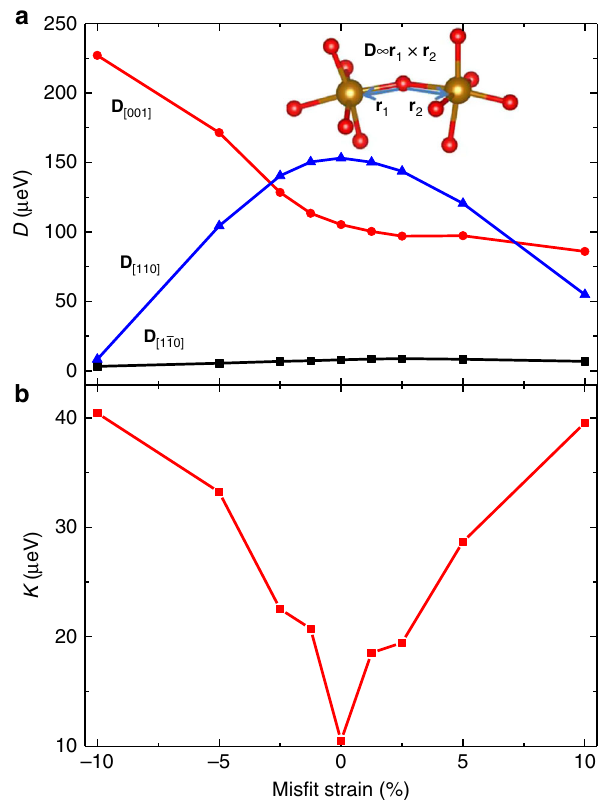
Fig. 4 Magnetic evolution with strain via spin Hamiltonian. a Strain (cid:1) (cid:3) (cid:1) (cid:3) dependence of the in-plane ( 110 , 001 ) and out-of-plane ([110]) components of the D vector. Inset shows a schematic of the Dzyaloshinskii – Moriya interaction between two Fe cations (gold) connected by oxygens (red). b Strain dependence of the single-ion- anisotropy constant K